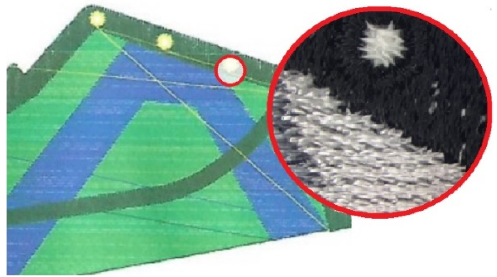
Figure 17. Part of the obtained embroidery .